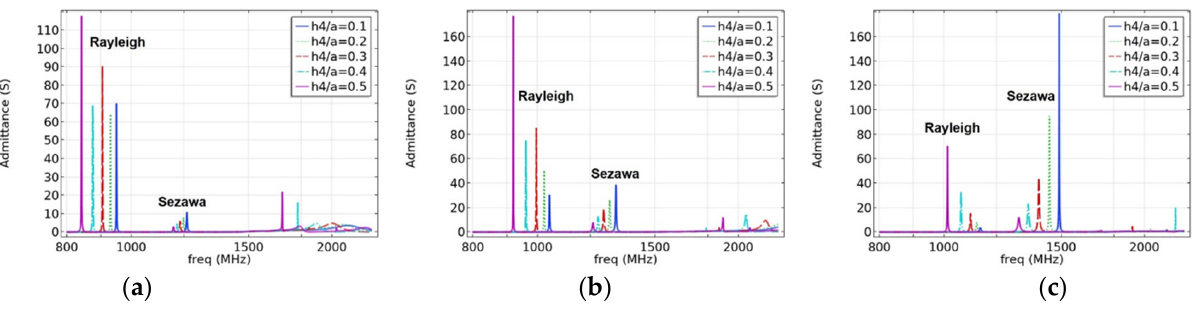
Figure 7. The effect of electrode thickness on admittance. ( a ) When ℎ (cid:2869) /𝑎 = 1.0 . ( b ) When ℎ (cid:2869) /𝑎 = 0.8 and ( c ) when ℎ (cid:2869) /𝑎 = 0.6 .